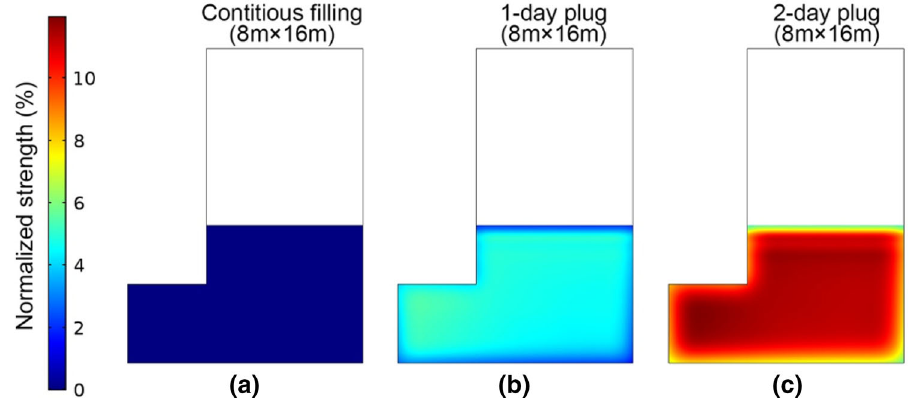
Fig. 20 Effect of filling strategy on spatial distribution of early-age strength of CPB after curing of plug layer: a continuous filling, b 1-day plug, and c 2-day